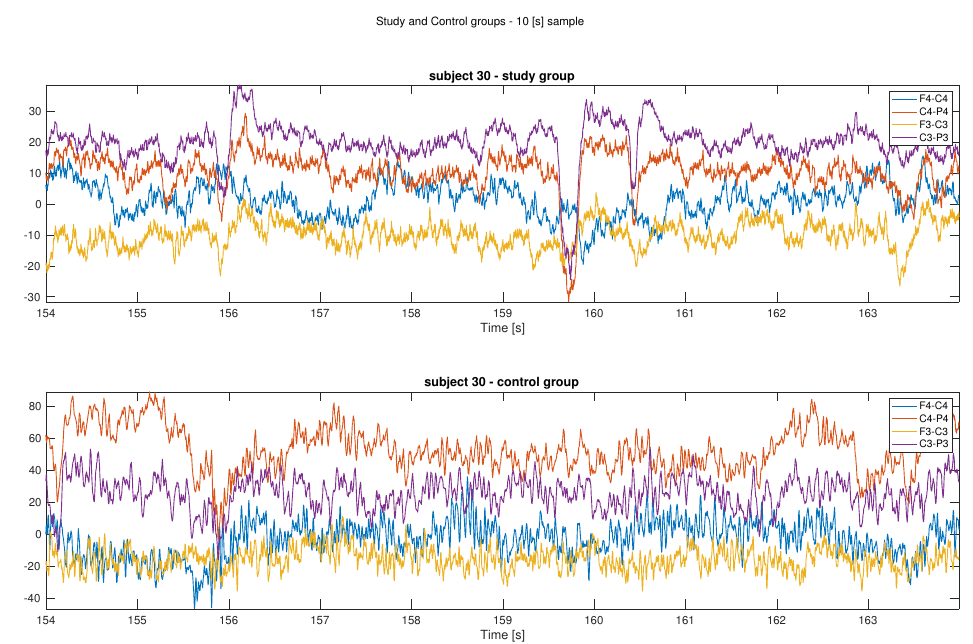
Figure 5. 10 [s] sample from four channels ( ’F4-C4’ , ’C4-P4’ , ’F3-C3’ and ’C3-P3’ )—study group subject ( top ) and control group subject ( bottom ). In Figure 6, a 10 [s] averaged data from two subjects (study—top, control—bottom) is presented.